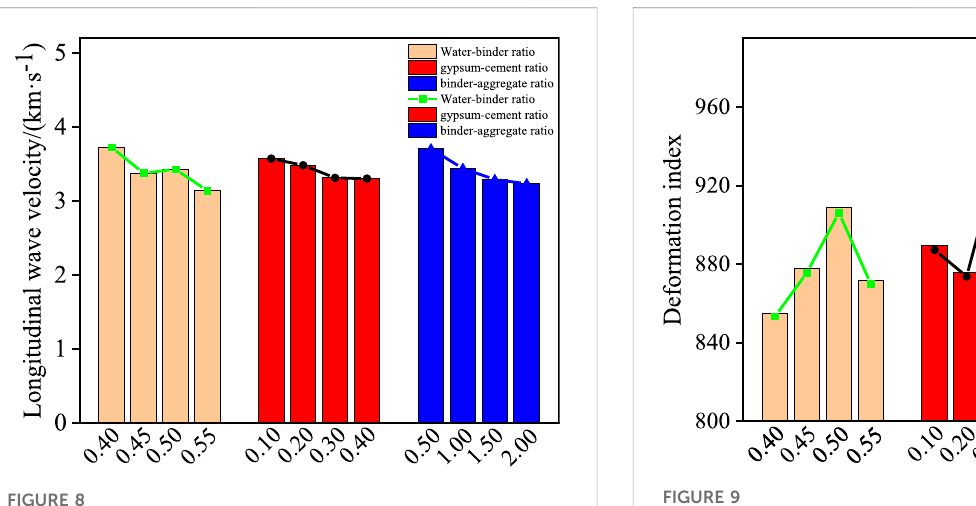
FIGURE 8 Sensitivity analysis of longitudinal wave velocity.